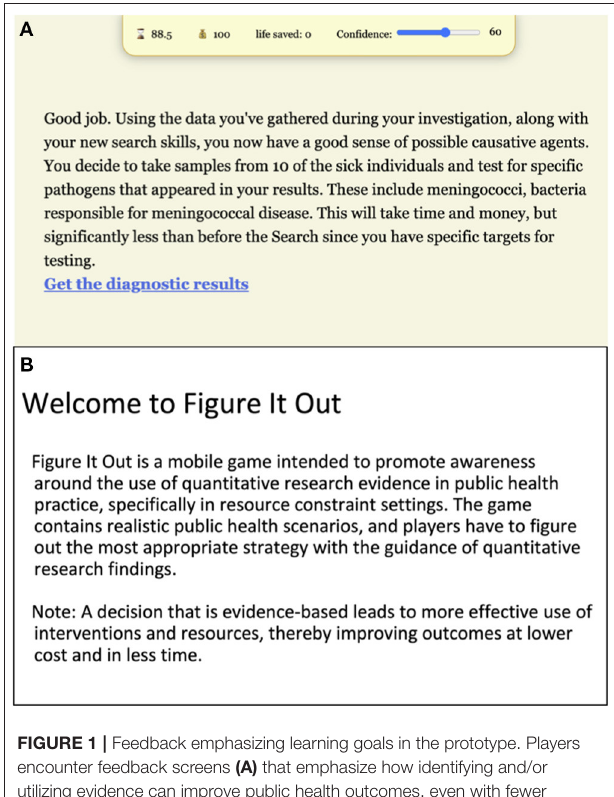
FIGURE 1 | Feedback emphasizing learning goals in the prototype. Players encounter feedback screens (A) that emphasize how identifying and/or utilizing evidence can improve public health outcomes, even with fewer resources used in the process. To ensure that this goal is emphasized explicitly and upfront, an introductory screen will be introduced (B) at the start of the scenario during the next iteration of the scenario.